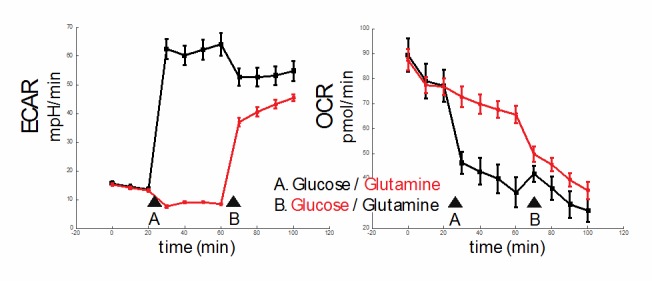
DOI:
http://dx.doi.org/10.7554/eLife.25217.039